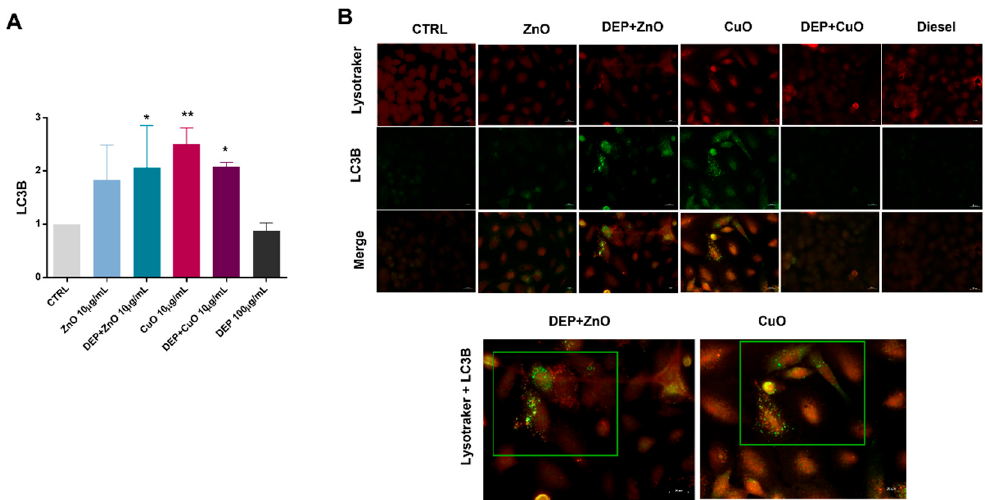
Figure 5. Autophagy detection by LC3B and colocalization with lysosomes. ( A ) The expression of LC3B, as a marker of autophagy, was evaluated by cytofluorimetric analysis in A549 cells exposed for 24 h to ZnO and CuO NPs (10 µ g/mL), alone or in mixture with DEPs (100 µ g/mL), and histograms represent the mean ± SE of the fold change of three independent experiments ( n = 3). In panel ( B ) are shown fluorescence microscopy images of A549 cells exposed to either MeO-NPs alone or mixtures, and stained for lysosomes (Lysotracker, red) and LC3B (green). Merged figures indicate the colocalization of LC3B puncta with acidic organelles (highlighted images of cells exposed to DEP + ZnO and CuO NPs). Statistical analysis was performed using one-way ANOVA with Dunnett’s multiple comparisons tests. ** p < 0.01 and * p < 0.05.